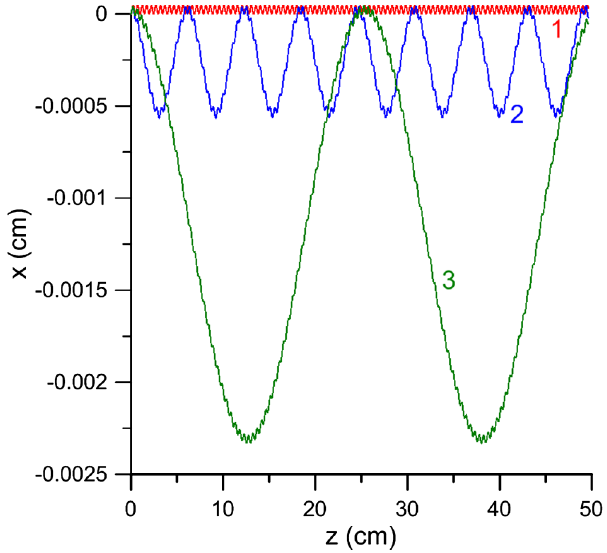
FIG. 2. Motion of sample electrons with K ¼ 0 : 4 . 1—in the field of counterpropagating wave only ( R ¼ 4 : 9 mm , (cid:10) ¼ 8 : 3 (cid:7) 10 (cid:5) 2 ); 2—in the field of copropagating and counterpro- pagating waves together ( R ¼ 4 : 9 mm , (cid:10) ¼ 8 : 3 (cid:7) 10 (cid:5) 2 ); and 3—in the field of copropagating and counterpropagating waves together ( R ¼ 9 : 6 mm , (cid:10) ¼ 1 : 9 (cid:7) 10 (cid:5) 2